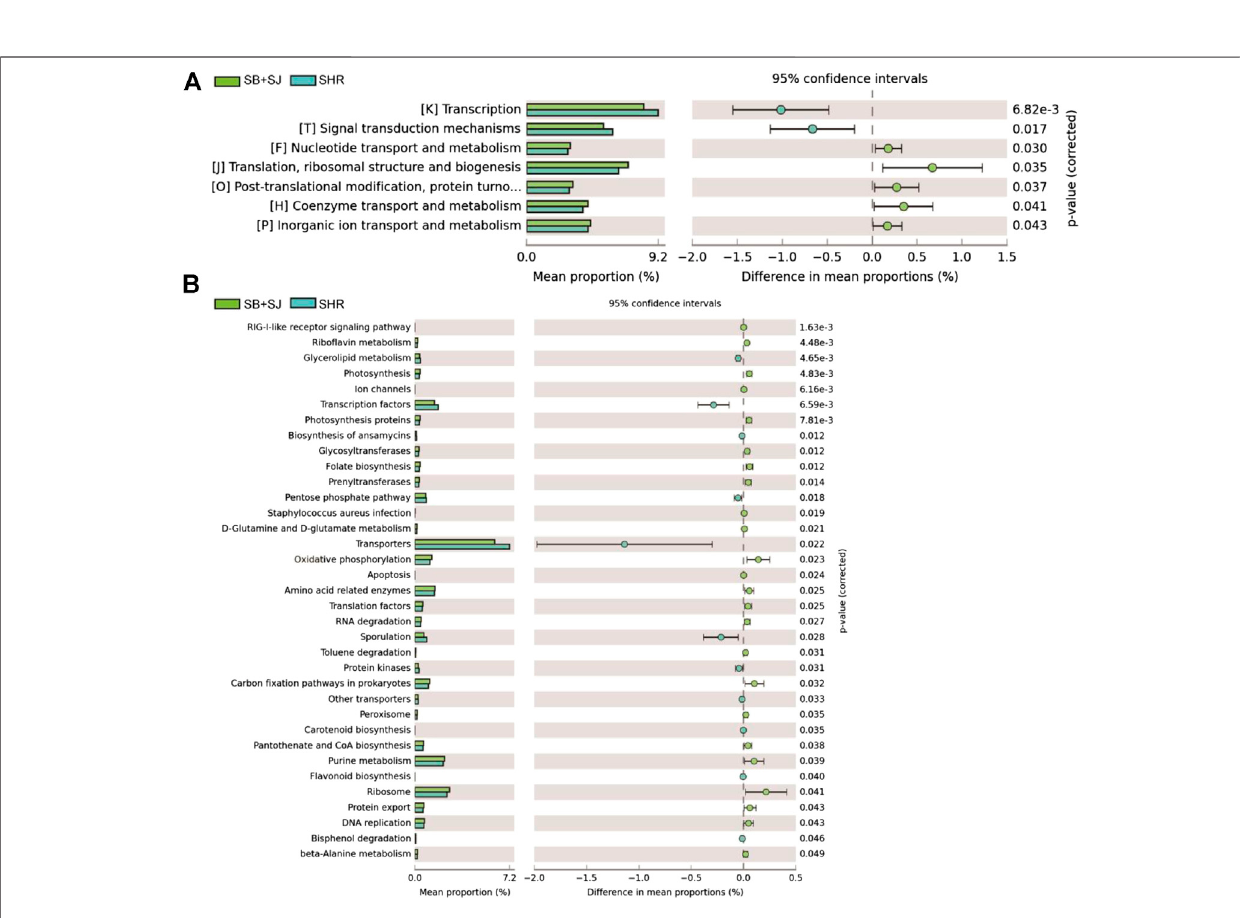
Frontiers in Pharmacology |